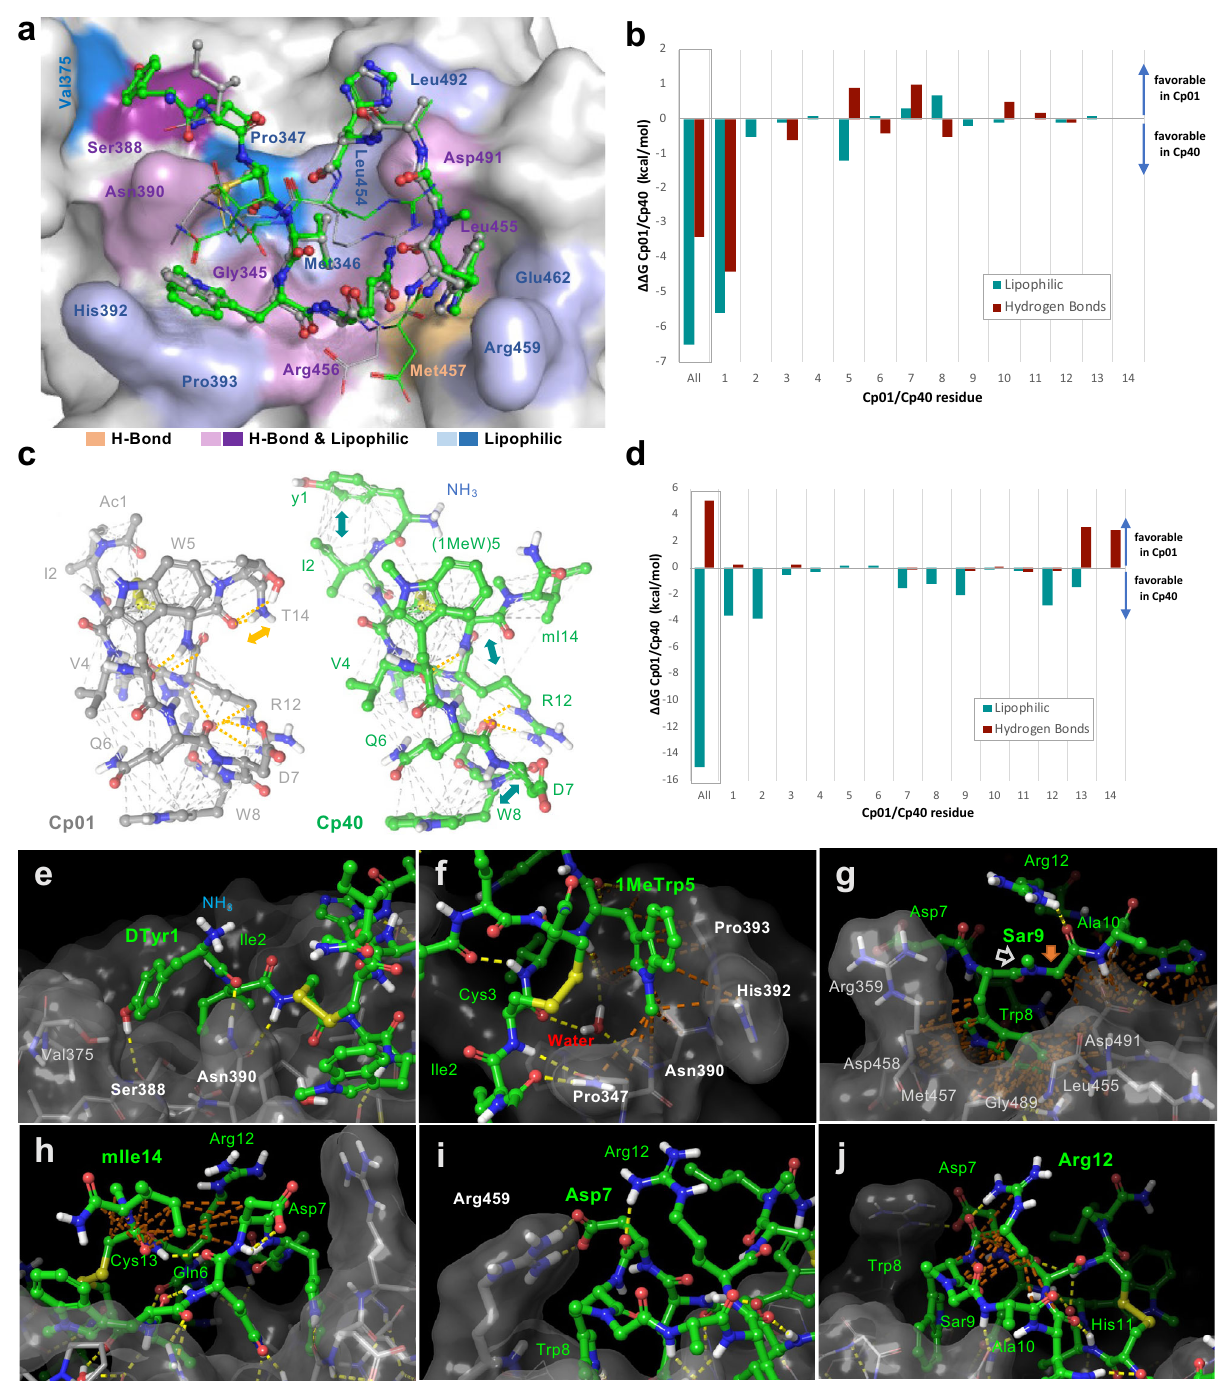
Fig. 3 | Interaction pro fi les of compstatin analogs Cp01 and Cp40 showing contributions of intermolecular (a,b) and (c,d) intramolecular H-bonds and hydrophobic contacts. a Contact residues on the target protein engaging in H-bonds(yellow),lipophiliccontacts(blue)orboth(purple)arehighlightedonthe surface of C3b. Contacts only present in Cp01 but not Cp40 are show in pastel shades.ThestructuresofCp01andCp40areshowningreyandgreenball-and-stick representation, respectively; residues not engaging in target binding are shown as lines. c Intramolecular contact networks in Cp01 (left) and Cp40 (right) showing H-bonds in yellow and hydrophobic contacts in grey. Analog-speci fi c H-bonds and